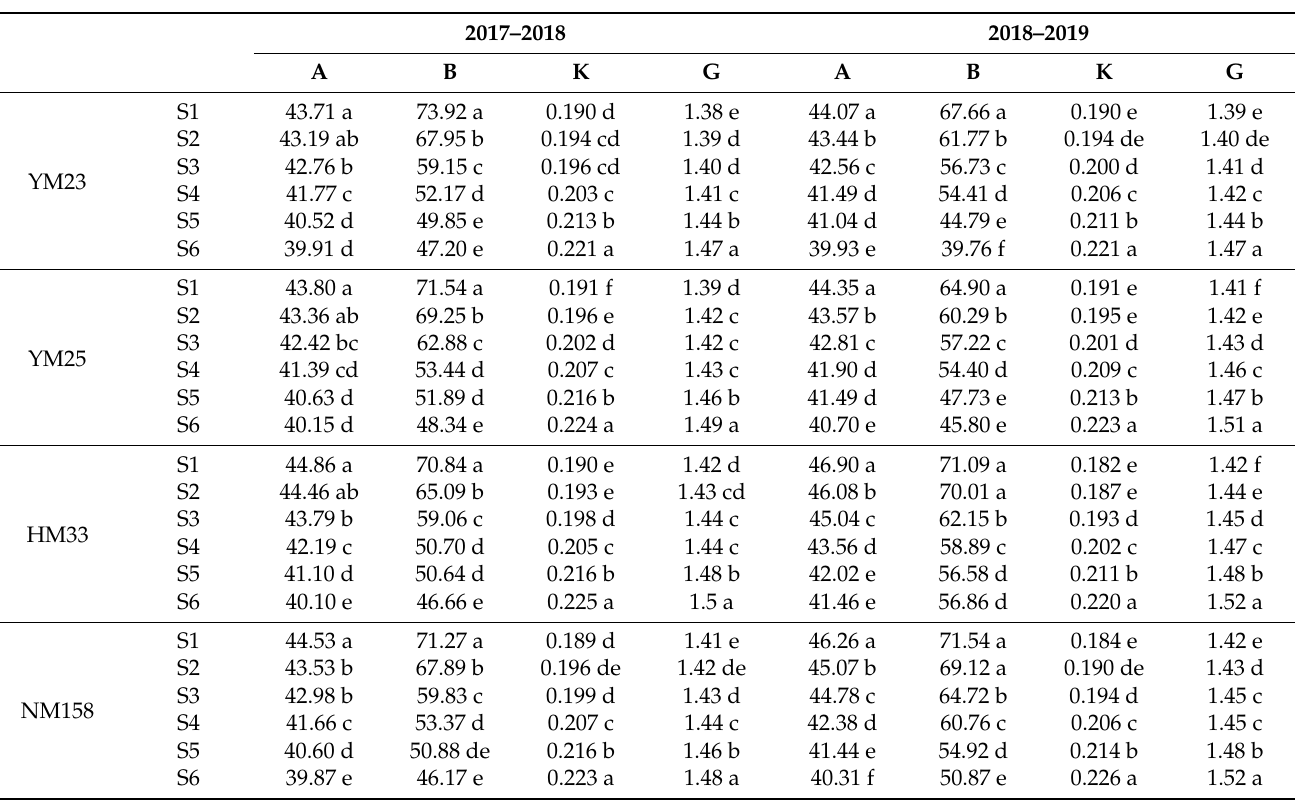
Table 3. Effects of different temperature and radiation on grain filling coefficient and average filling rate of